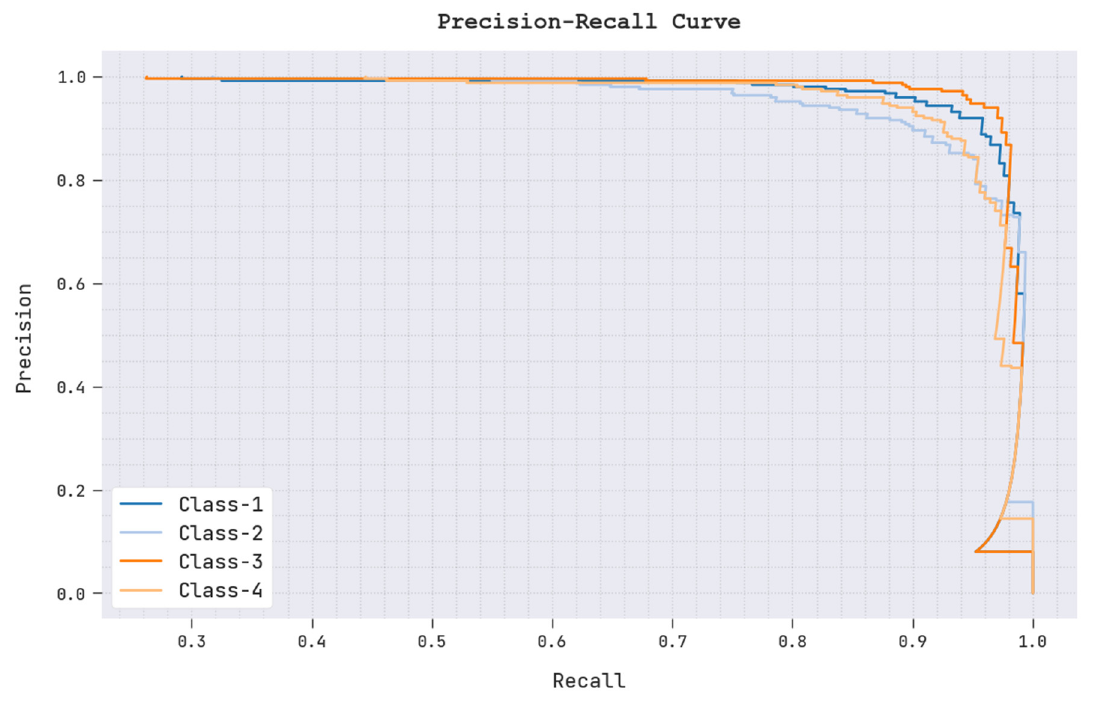
Figure 9. Precision-recall analysis of the AOTL-CDA3S system.